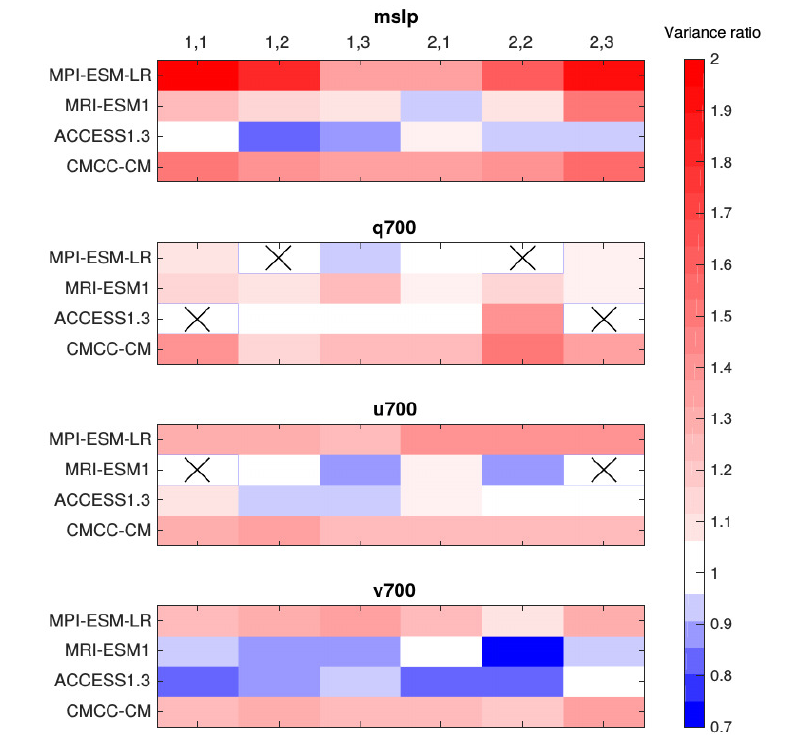
Figure 10. Spatial variance ratio as an average for the period of study for mslp, q700, u700, and v700. Weather regimes that were not captured by models are marked with the “ × ” symbol, in accordance with the blank spaces in Tables S2 and S3 of Supplementary Materials.